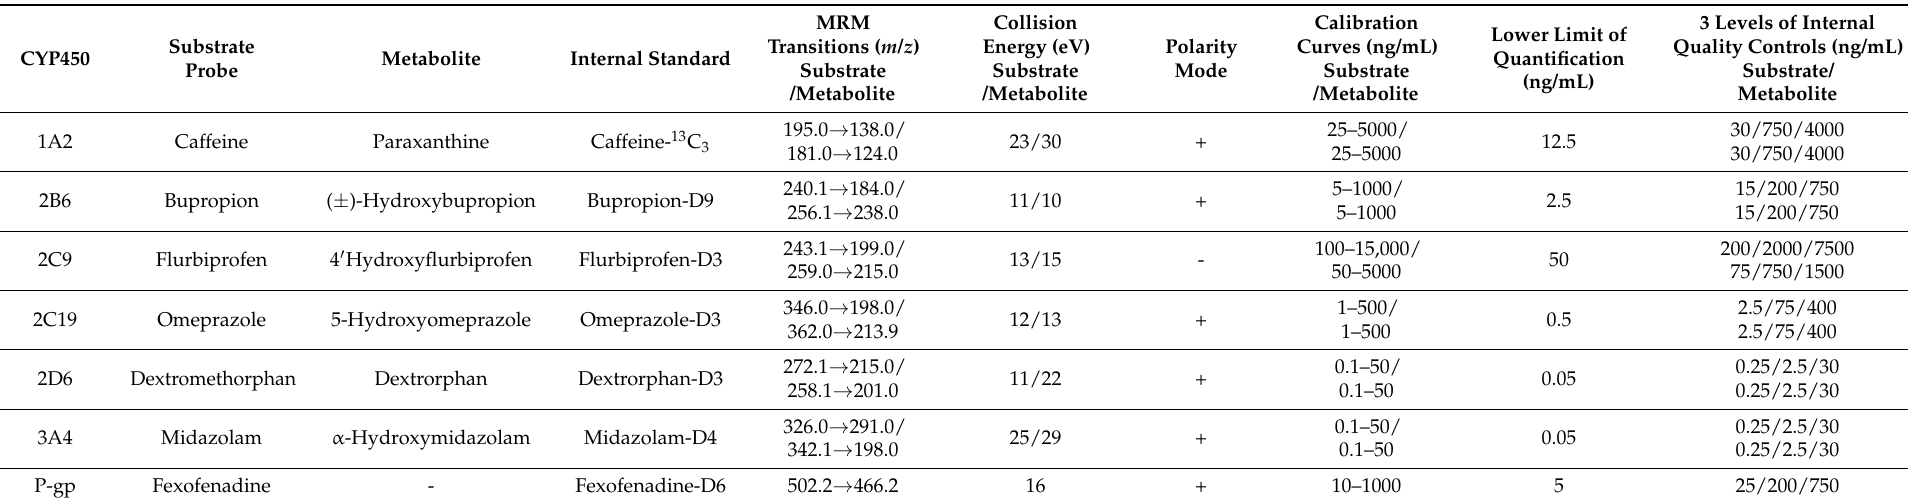
Table A4. Parameters of LC/MS-MS methods.